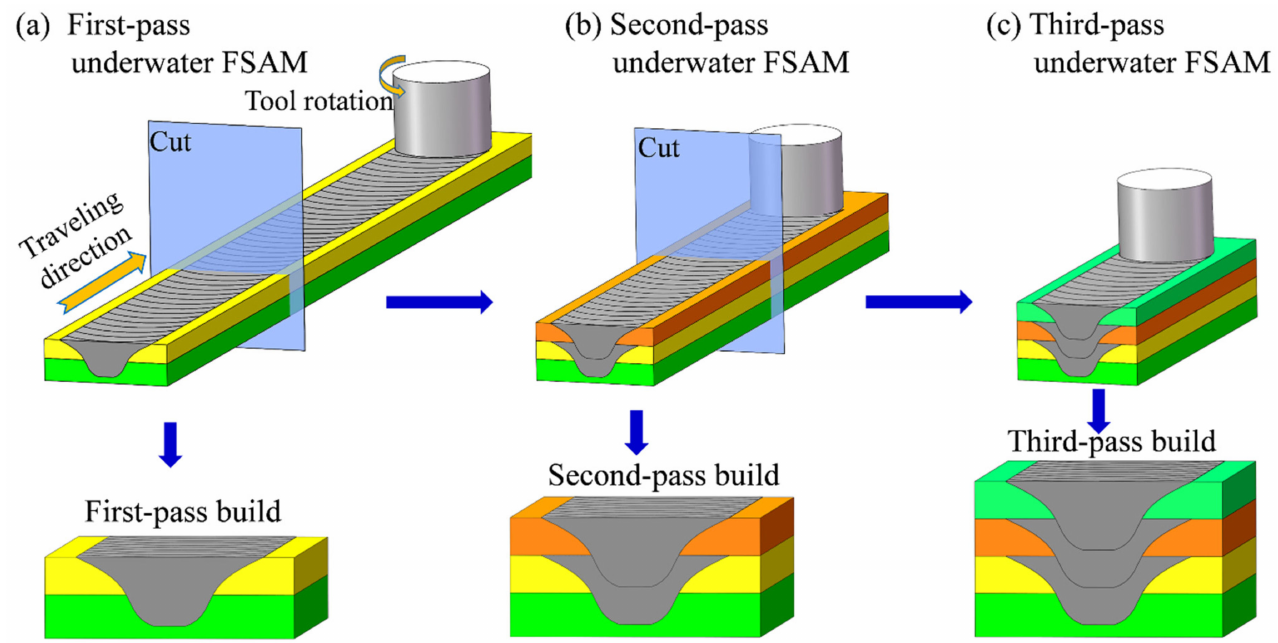
Figure 1. Schematics of ( a ) first-pass underwater friction stir additive manufacturing (FSAM); ( b ) second-pass underwater FSAM; and ( c ) third-pass underwater